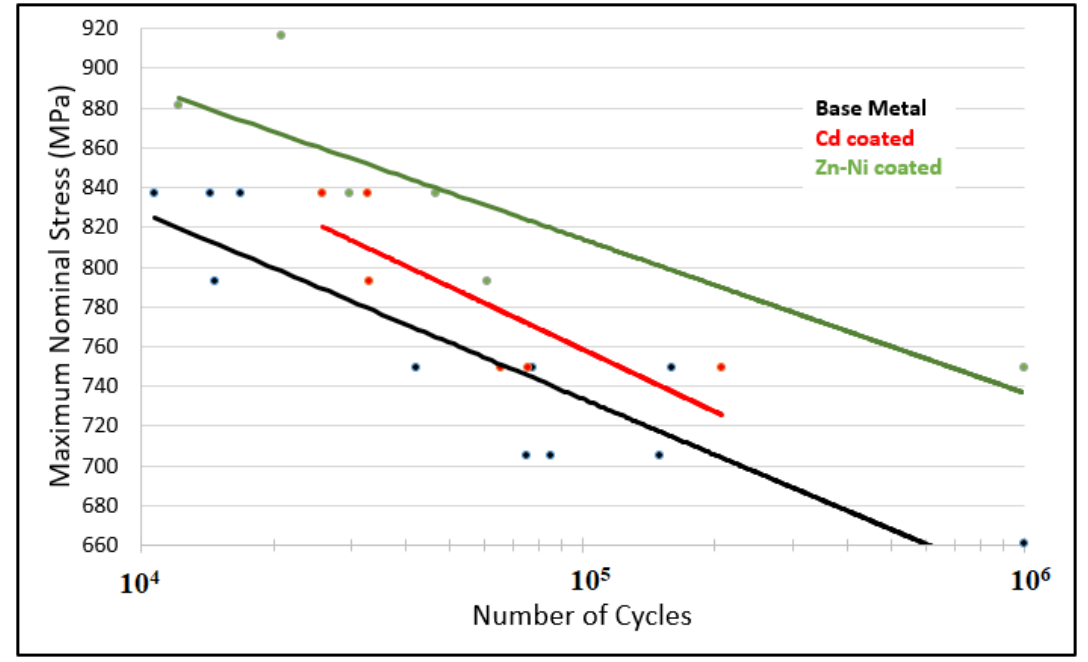
Figure 7. Fatigue life, standard specimens (ASTM E466) [17].